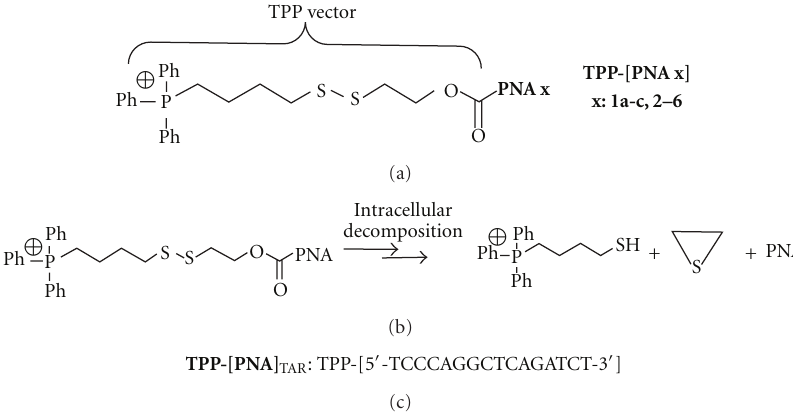
Figure 4: (a) Structures of the TPP conjugates of PNAs 1a–c , 2–6 . (b) Schematic representation of the intracellular degradation mode of TPP-PNA conjugates (from [28]). (c) Structure of the reference compound used in this study (16-mer antisense TPP-[PNA] TAR